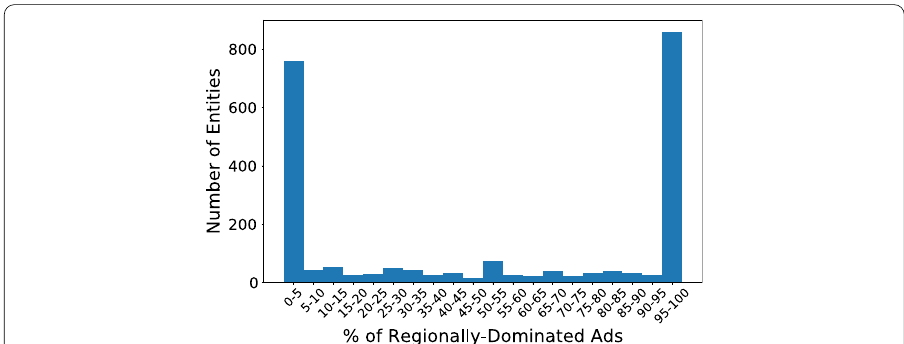
Fig. 5 Distribution of the percentage of regionally-dominated ads per funding